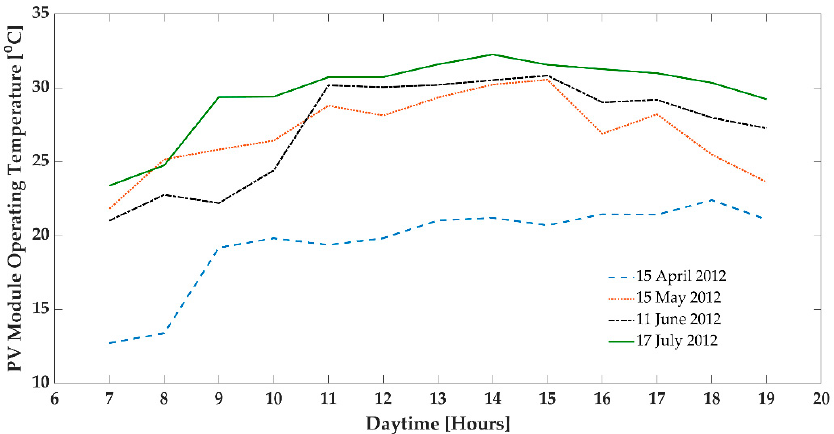
Figure 12. PV module operating temperature vs. daytime hours from 7 a.m. to 7 p.m. from experimentally recorded data over 4 days, 15 April, 15 May, 11 June, and 17 July, at Tehran’s meteorological station in 2012.